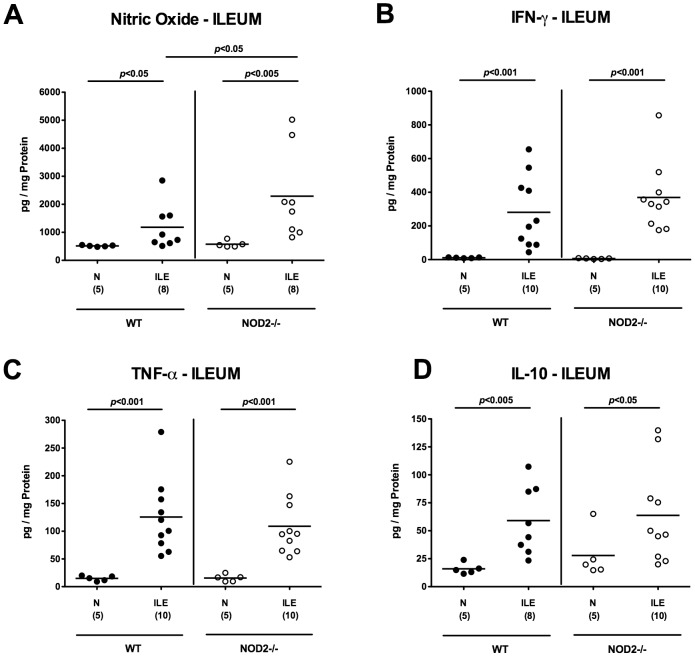
Small intestinal cytokine responses in NOD2 deficient mice following ileitis induction.(A) Nitric oxide, (B) IFN-γ, (C) TNF-α, and (D) IL-10 levels were determined in ex vivo ileal biopsies derived from C57BL/6 wildtype (WT; black circles) and NOD2 deficient (NOD2-/-; white circles) seven days following ileitis induction (ILE) as described in methods. Naive mice served as negative controls (N). Numbers of analyzed mice (in parentheses), means (black bars) and levels of significance (P-values) as compared to the respective groups (determined by Mann-Whitney-U test) are indicated. Data shown are representative for three independent experiments.